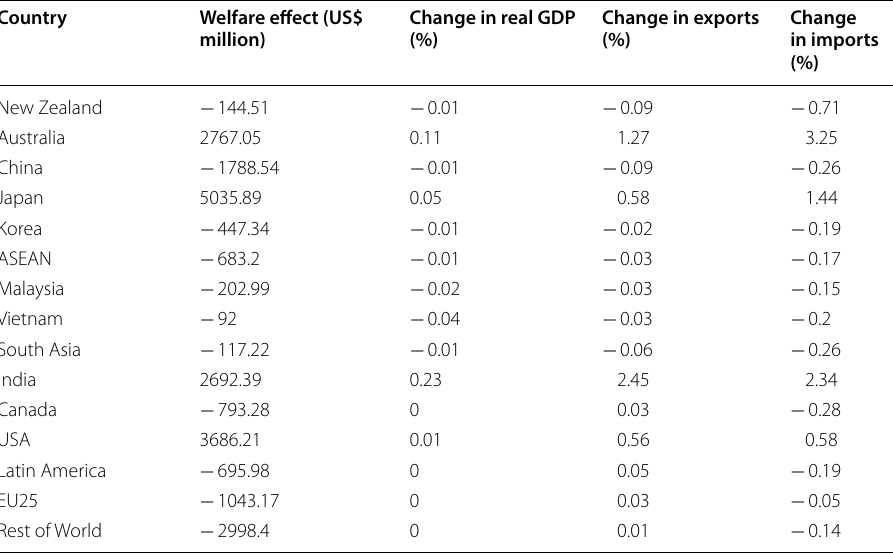
Table 3 Macroeconomic impact of tariff eliminations under ‘Indo-Pacific 1’. Source: Authors’ simulation from GTAP version 9